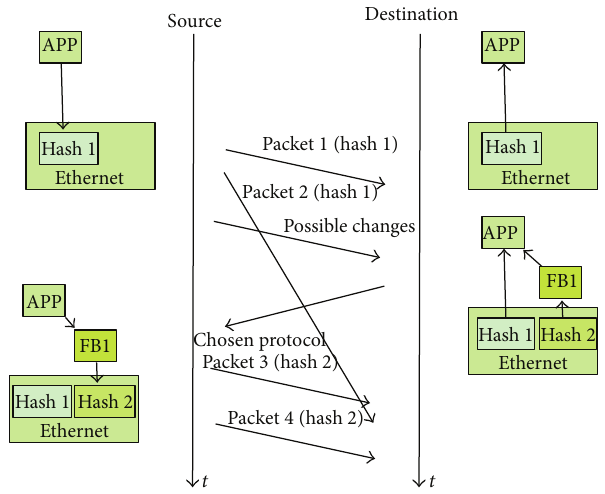
Figure 2: Updating the dynamic protocol stack over